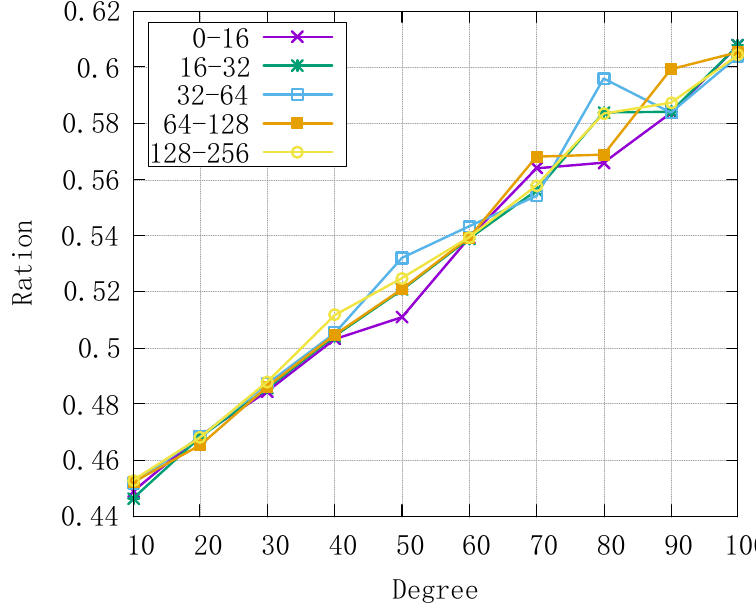
Figure 7. Proportion of edge server